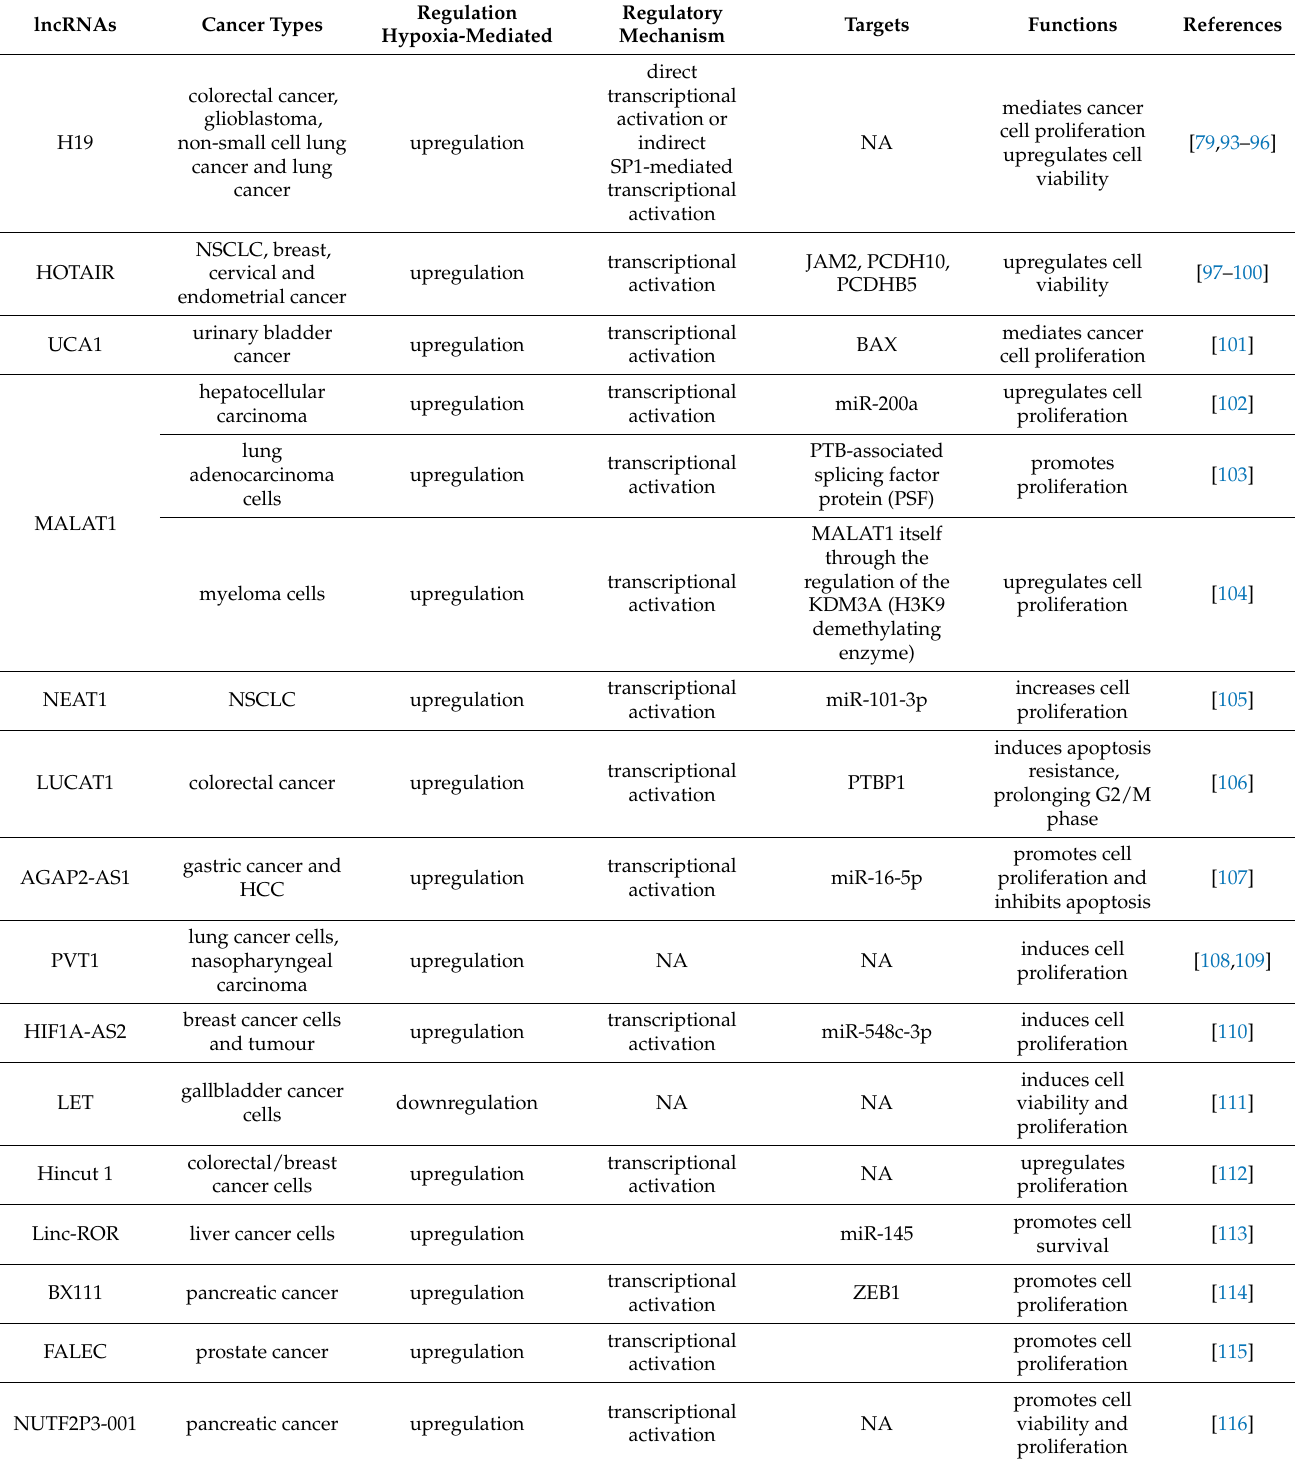
Table 2. List of hypoxia-responsive long non-coding RNAs involved in cell proliferation, apoptosis and cell cycle regulation.